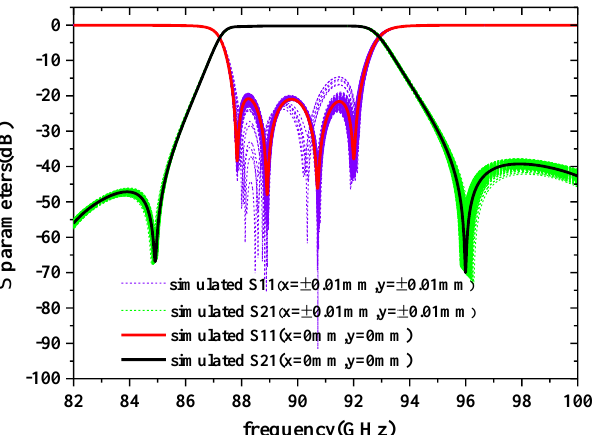
Figure 9. Sensitivity analysis of the designed filter based on simulations, x represents a move in the X direction, and y represents a move in the Y direction.